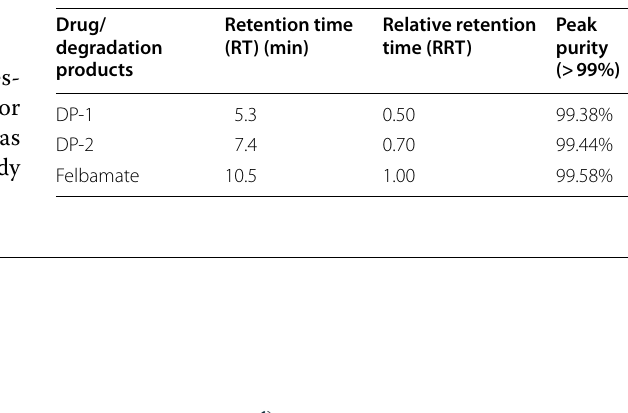
Table 2 Retention time, RRT and peak purity for the drug and the degradation